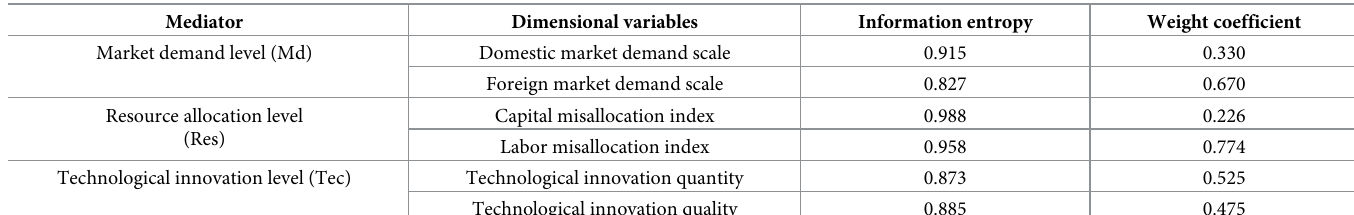
Table 3. Information entropy and weight of dimensional